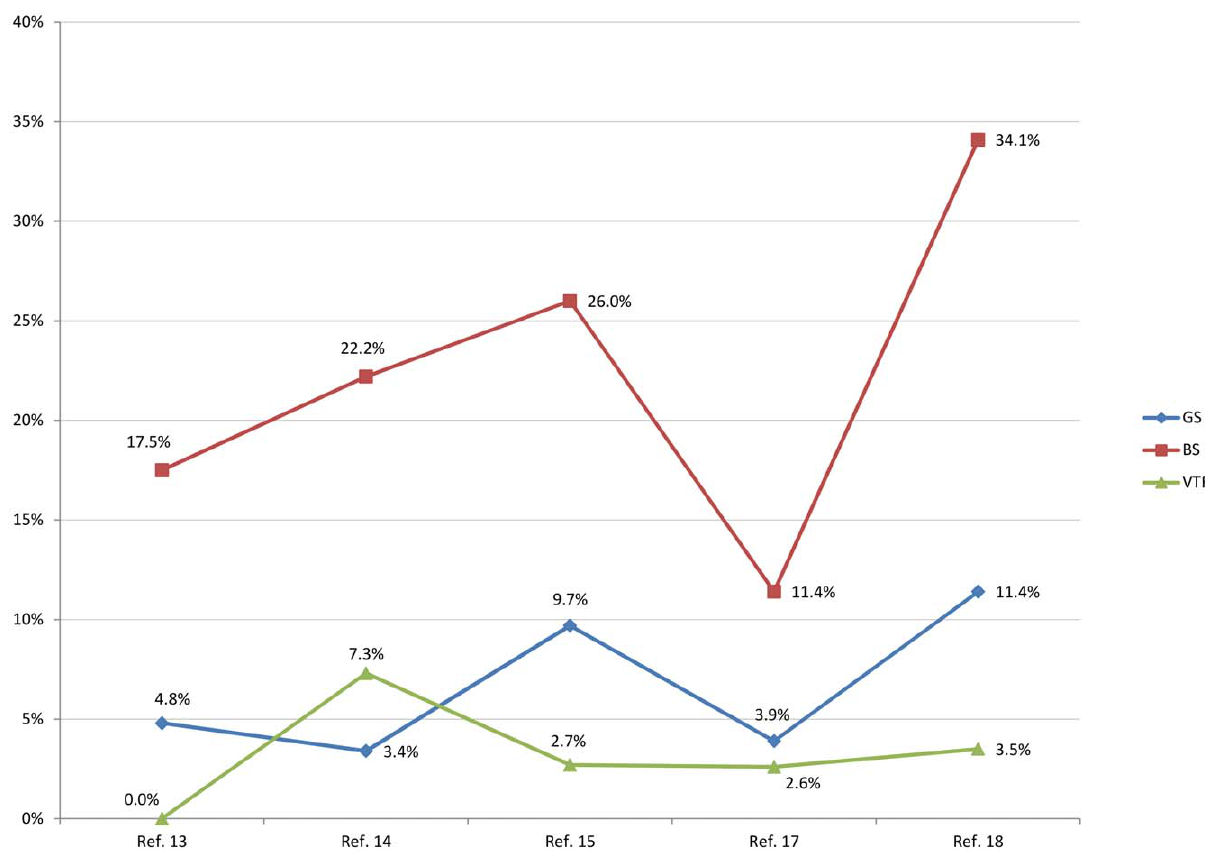
Figure 1. T.cruzi seroprevalence and vertical transmission rate in the five studies performed in maternity hospitals. GS, Global T. cruzi seroprevalence; BS, T. cruzi seroprevalence among Bolivians; VTR, vertical transmission rate; Ref,